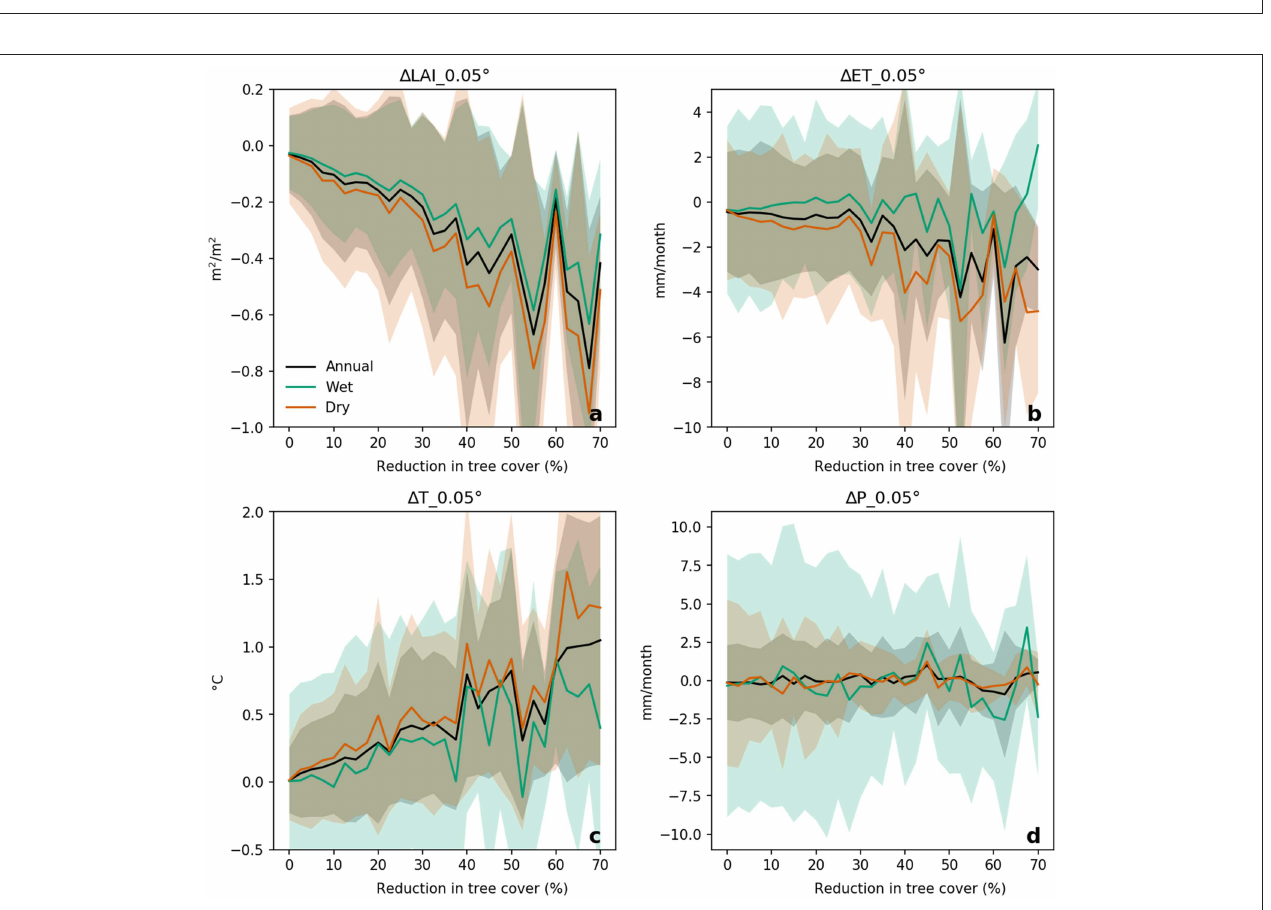
FIGURE 5 | Changes in annual mean, wet season (data from wettest 3 months, calculated per pixel) and dry season (driest 3 months, calculated per pixel) 0.05 ◦ remotely-sensed leaf area index (a) , evapotranspiration (b) , daytime land surface temperature (c) , and precipitation (d) , in response to reduction in tree cover. Data come from all forest pixels that lost their intact status between 2000 and 2013. Values are expressed relative to the changes observed over neighboring intact forest, for the period 2001–2013.